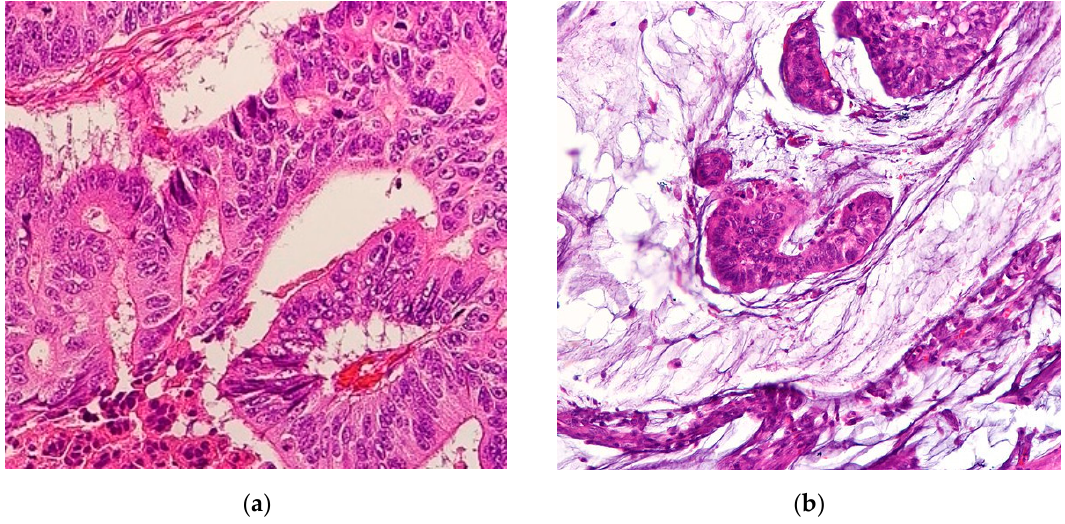
Figure 1. ( a ) Representative histological slide of colorectal adenocarcinoma. ( b ) Representative histological slide of colorectal mucinous adenocarcinoma, illustrating abundant extracellular mucin within more than 50% of the tumor area. Figures sourced from Wikimedia Commons, public domain [8,9].